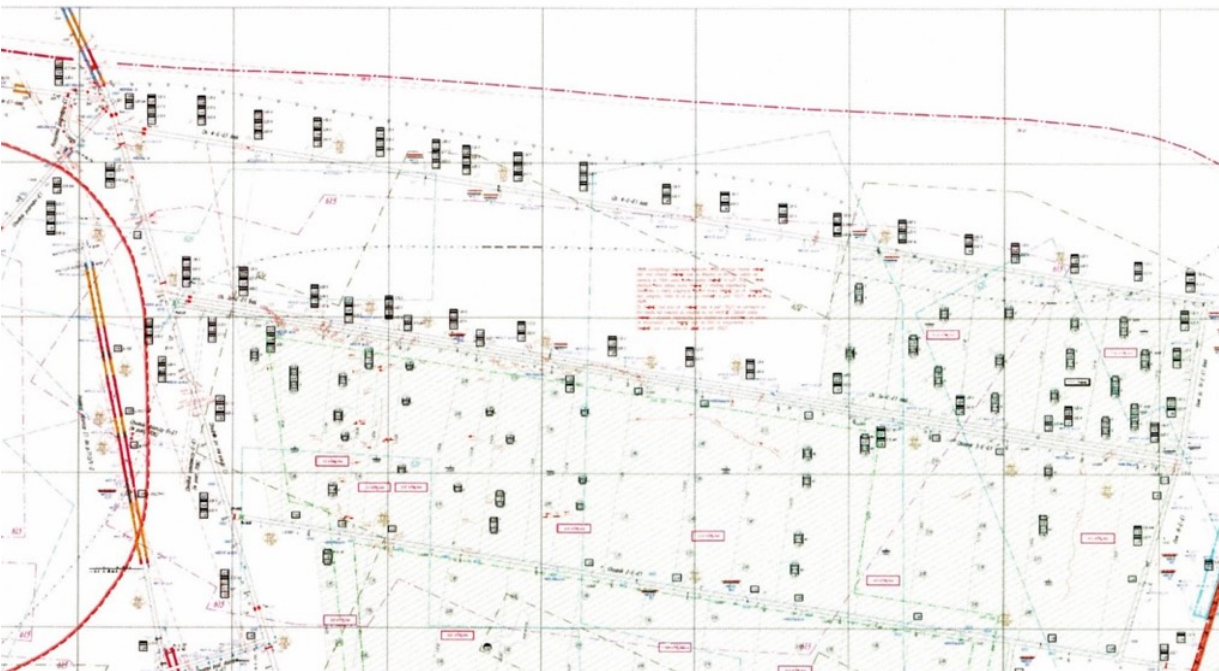
Figure 9. Seam 703/1 with longwall IV.